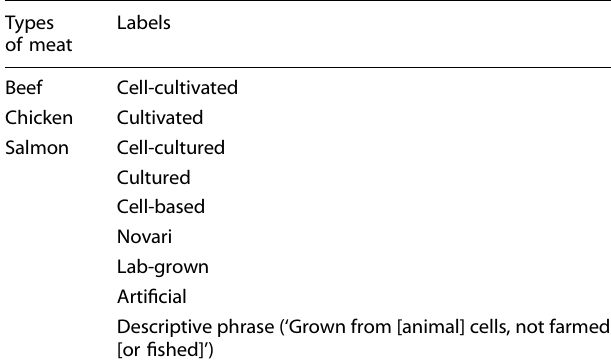
Table 8. Three types of meat and nine labels used in the